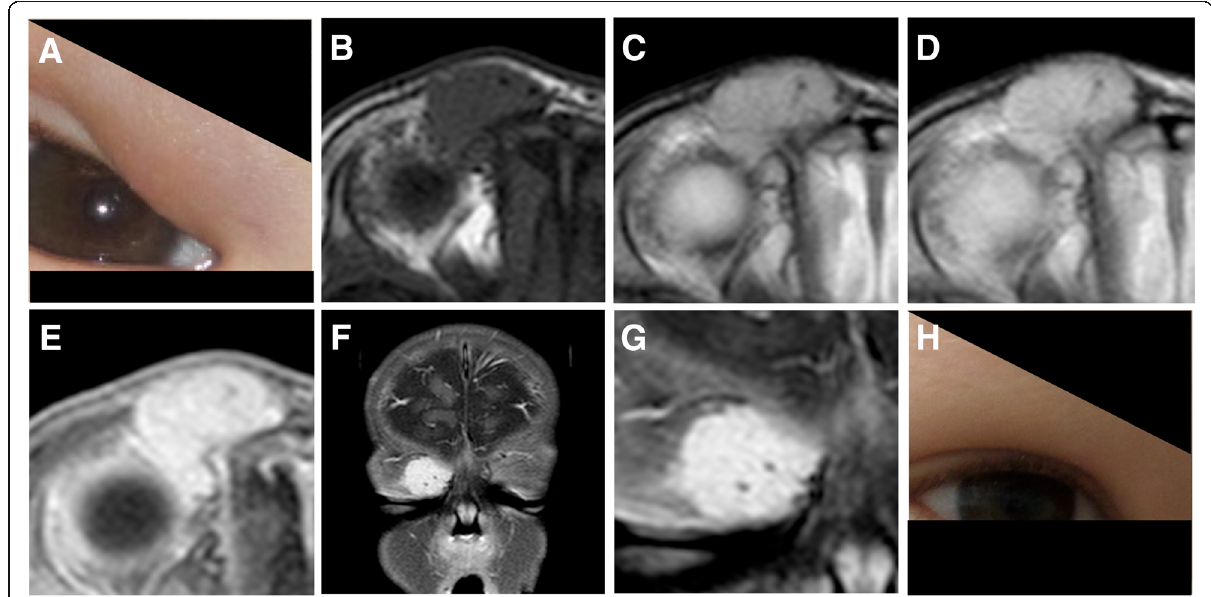
Fig. 2 Infantile hemangioma in a 5-month-old boy invading the eyelid ( a ). The hemangioma exhibits a homogeneous architecture with only a few flow voids within the lesion ( b – d ). Similarly, a homogeneous contrast enhancement is visible after gadolinium administration ( e – g ). Two years later, the hemangioma involuted completely without any residual mass ( h